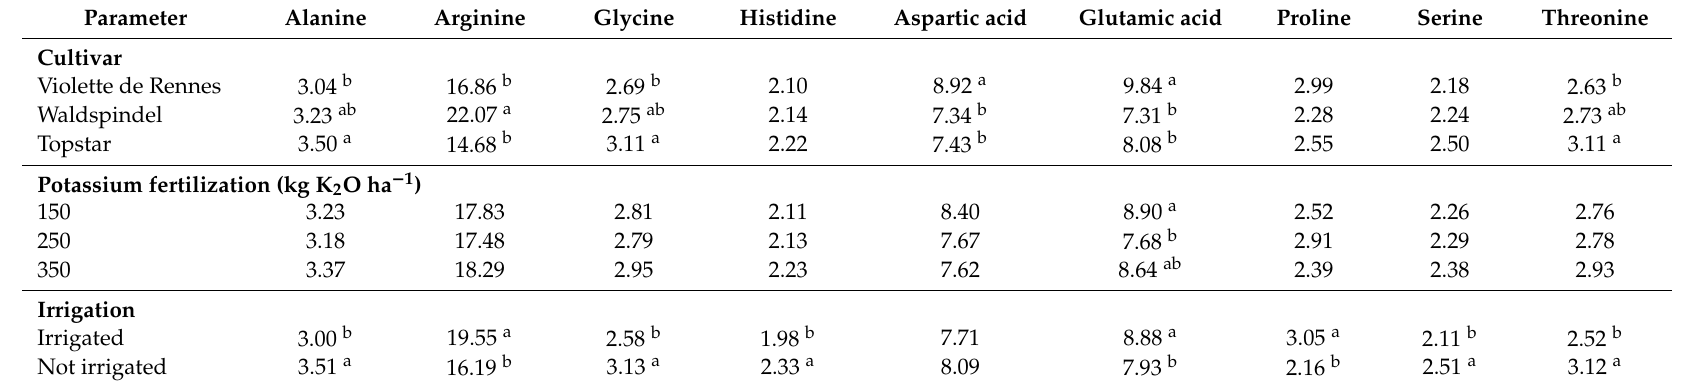
Table 5. The e ff ect of experimental factors on the content of endogenous amino acids (g 100 g − 1 of protein) in Jerusalem artichoke tubers. Parameter Alanine Arginine